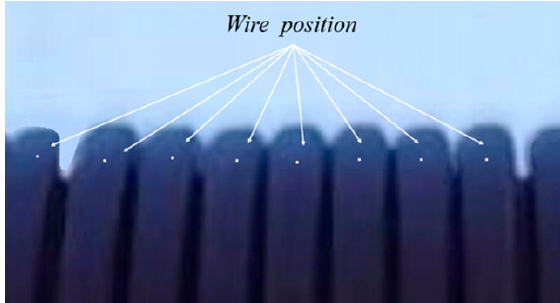
Figure 20. Traverse outline recognition result.